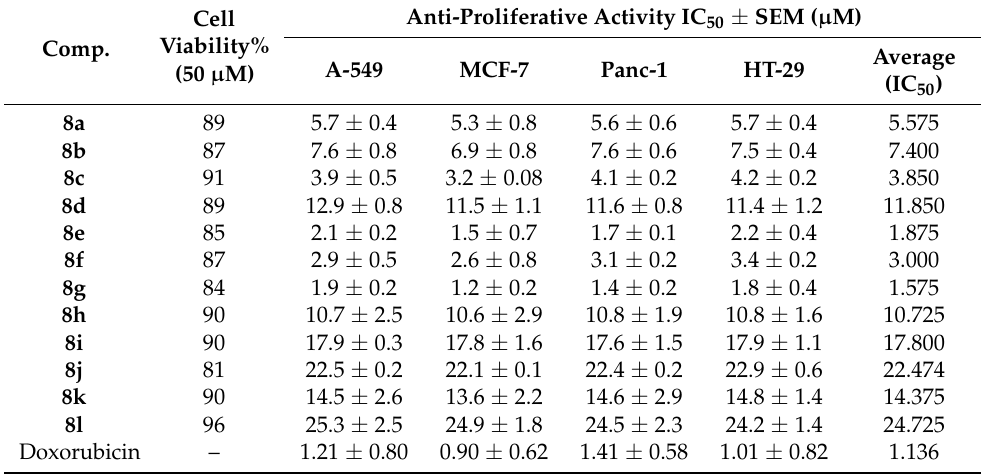
Table 3. Anti-proliferative activity of compounds 8a – l and doxorubicin.